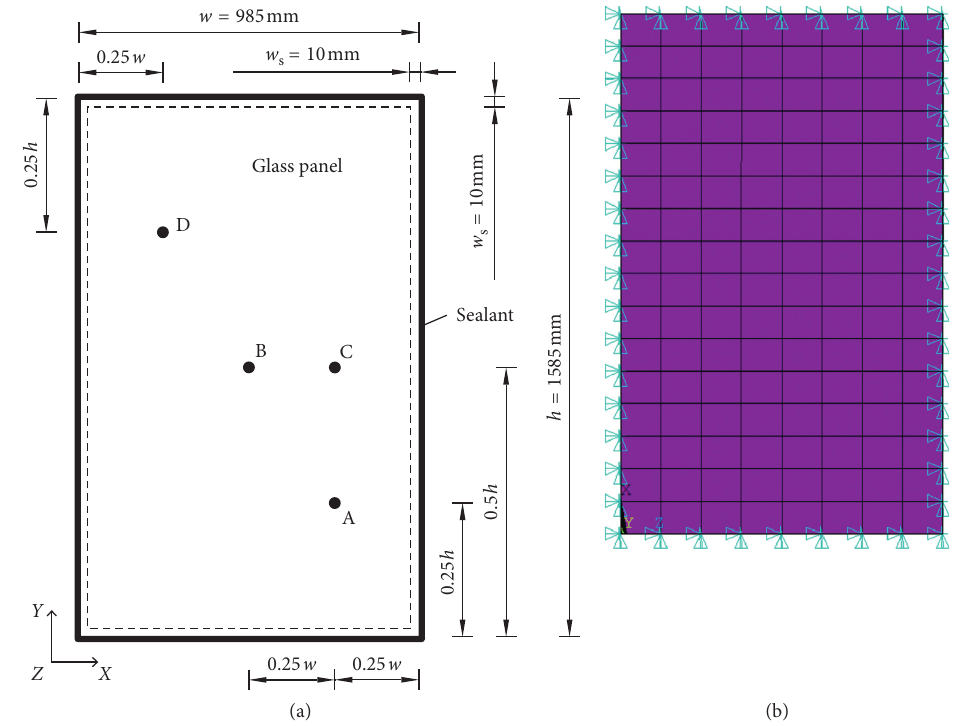
Figure 1: Model of a panel. (a) Sketch of sensor locations; (b) finite element